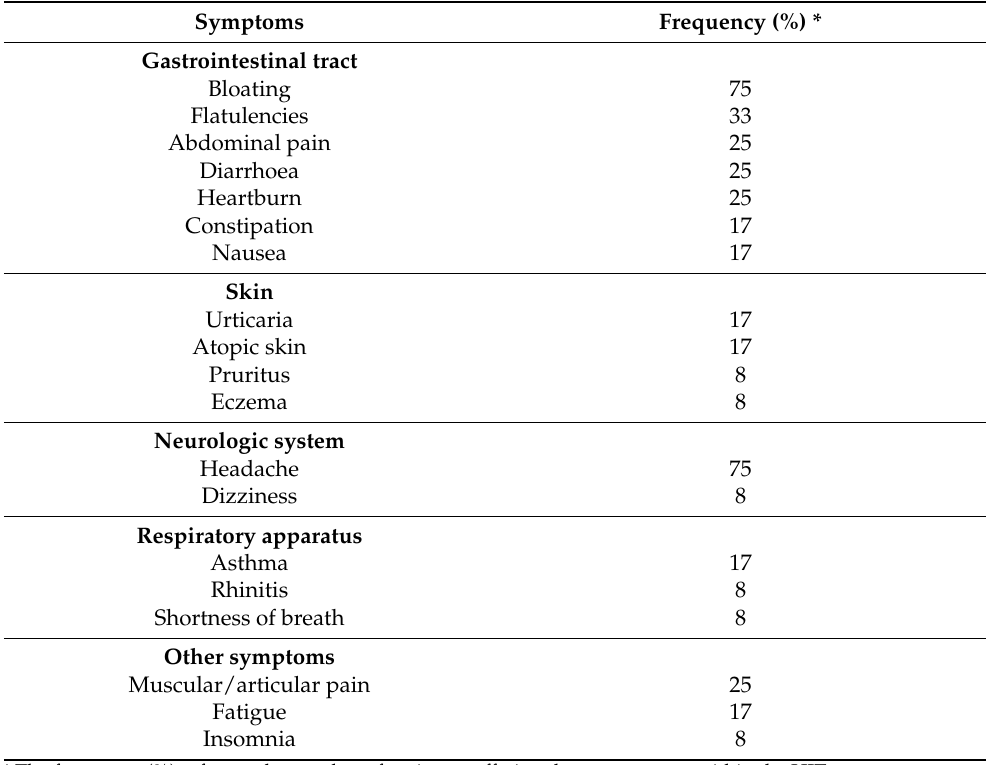
Table 2. Clinical manifestations reported by the HIT group ( n =